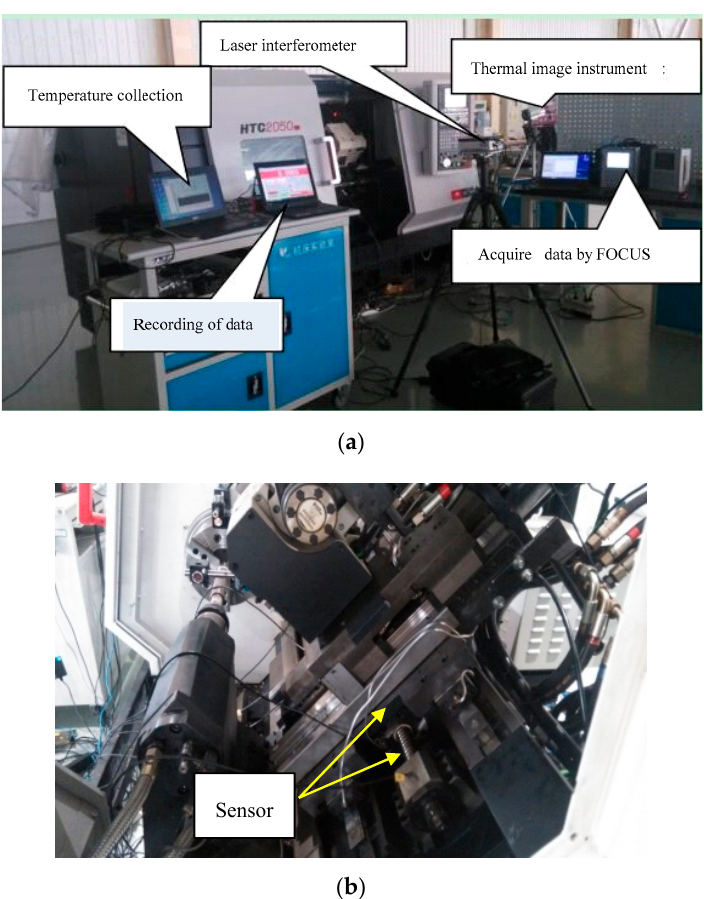
Figure 1. Experimental setup for measuring thermal characteristics. ( a ) Experimental equipment; ( b ) thermal sensor